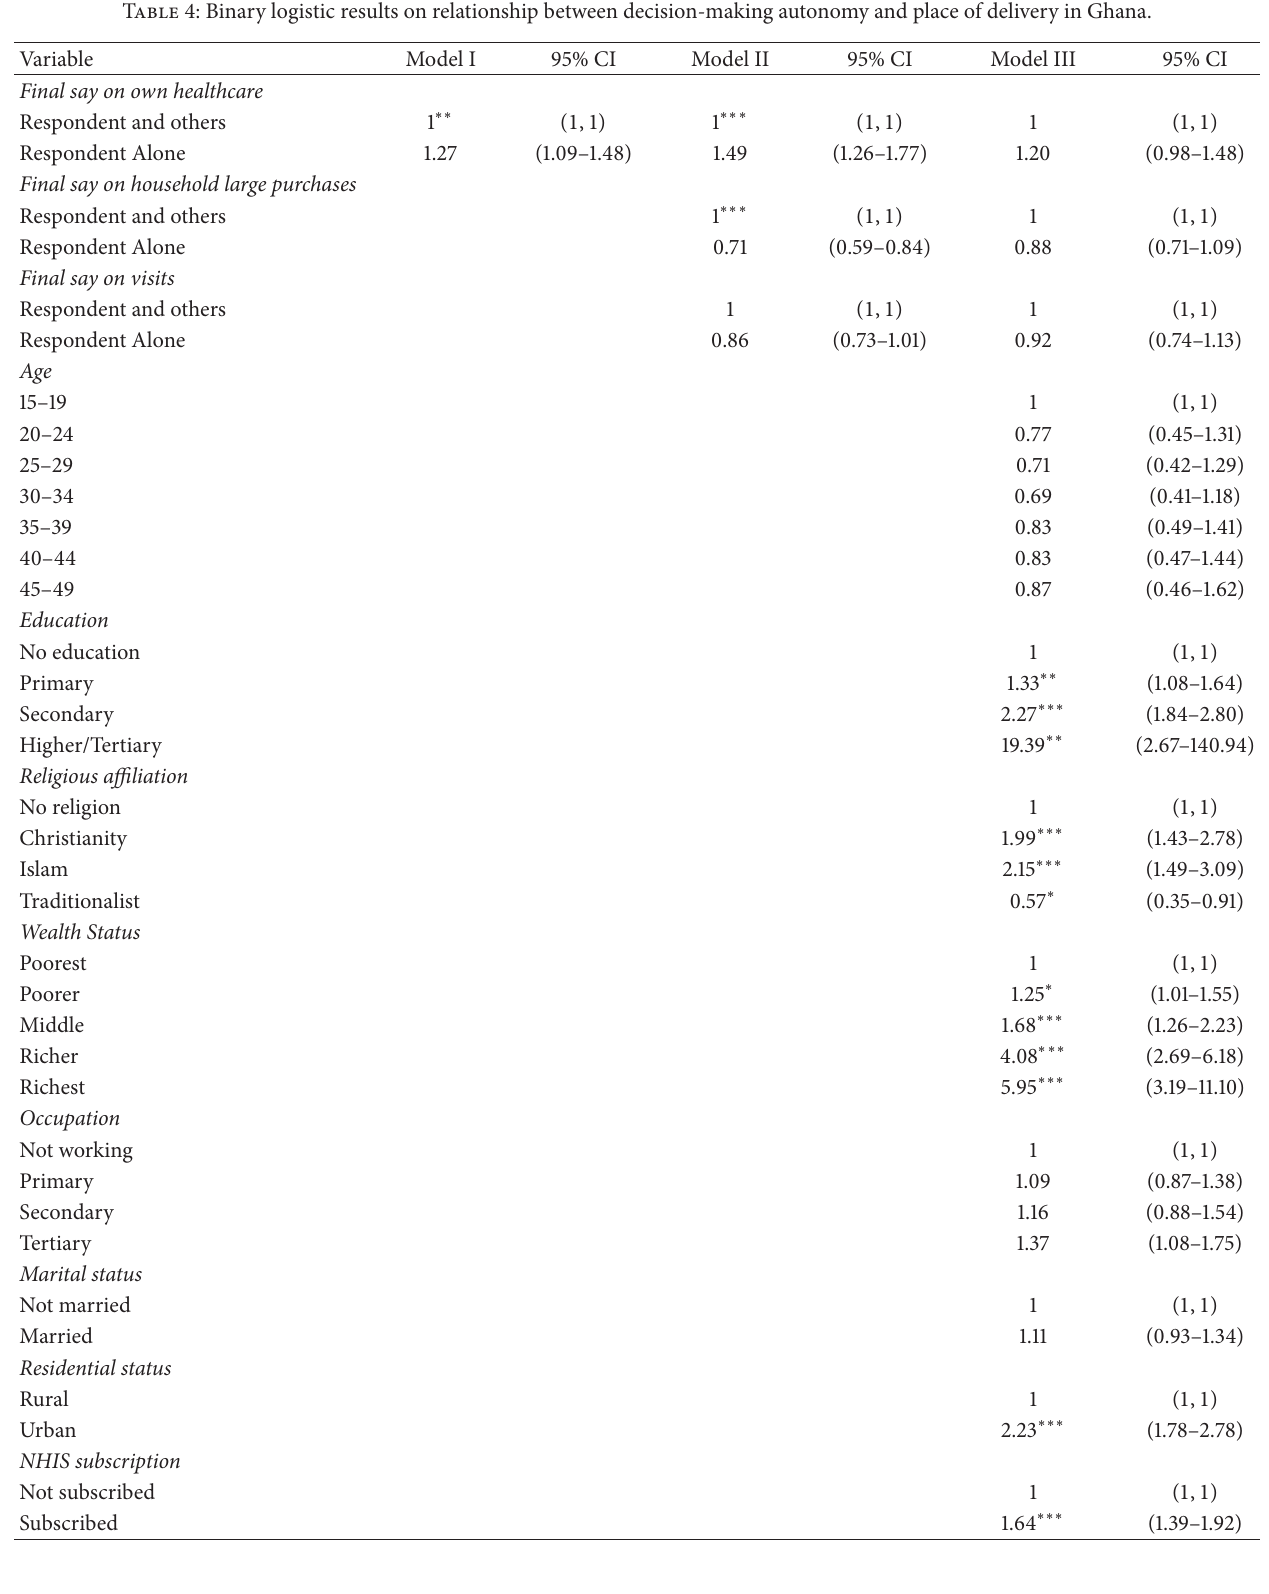
Table 4: Binary logistic results on relationship between decision-making autonomy and place of delivery in